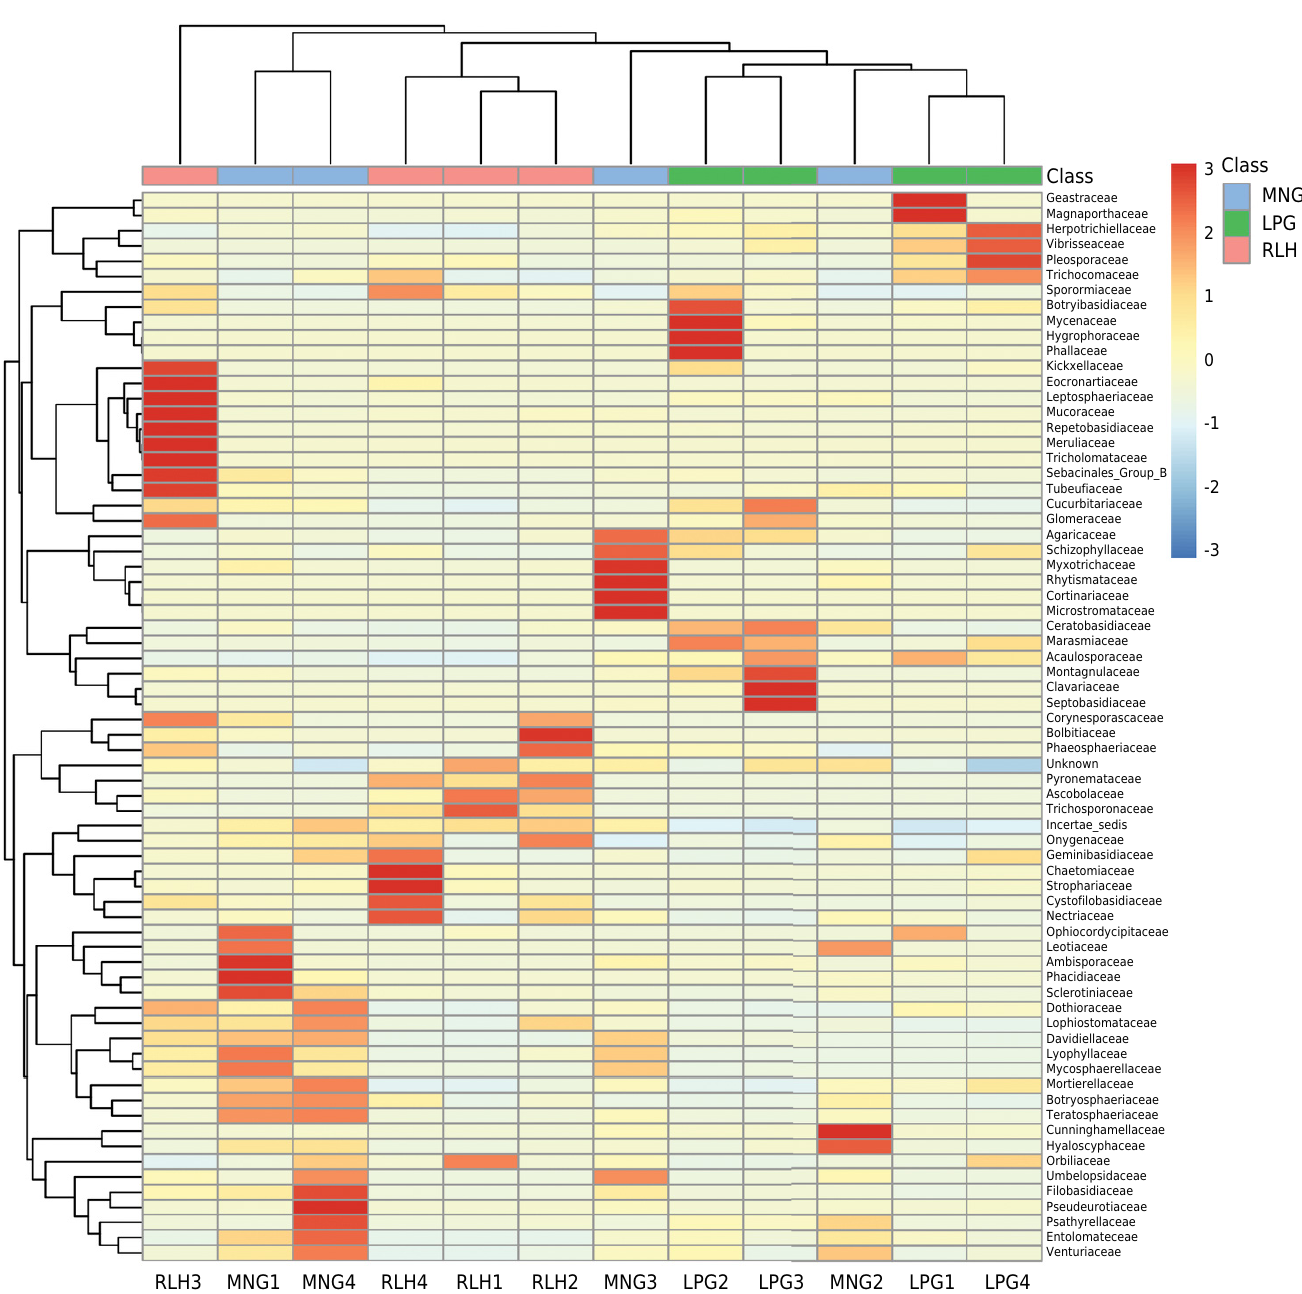
Figure 7. Heatmap analysis of the fungal community of soil samples subjected to RLH, LPG, and MNG treatments collected at four times during the year and multiple samples similarity tree at the family level. The connecting lines on top describe the fungal communities clustering of each sample. The connecting lines on the left side describe the clustering of each fungus. The closer the color close to red was, the more dominant microorganism was. Note: RLH: raising laying hens under forest; LPG: cultivating Lolium perenne grass under forest; MNG: maintenance of native grass under forest. The number after the treatment symbol means: 1 = spring; 2 = summer; 3 = autumn; 4 =